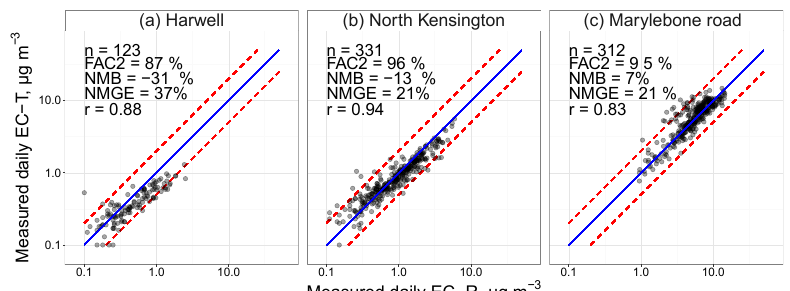
Figure A1. Scatter plot of measured daily average EC split from TC using transmittance (EC-T) and EC split from TC using reflectance (EC-R), year 2012. Data below the detection limit ( < 0.1µgm − 3 ) have been removed, leading to the lower number of data points for Harwell.